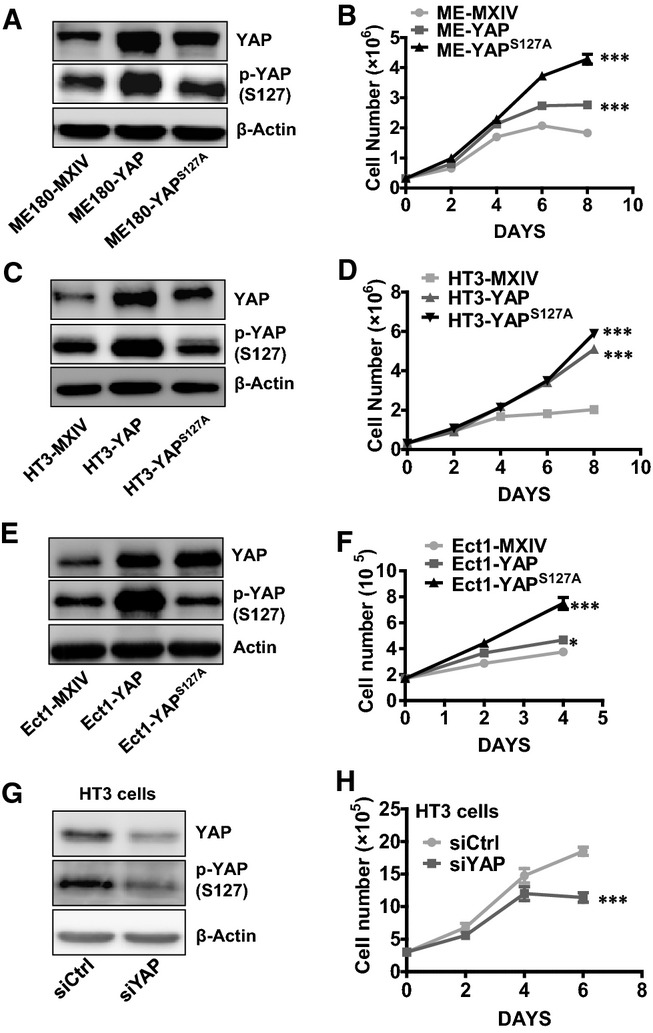
Effect of YAP on the proliferation of normal and cancerous cervical cells
A, C, E Western blot analysis showing levels of YAP and phosphorylated YAP in ME180 cell lines [ME180-MXIV (control), ME180-YAP, and ME180-YAPS127A cells] (A); HT3 cell lines [HT3-MXIV (control), HT3-YAP, and HT3-YAPS127A cells] (C); and Ect1 cell lines [Ect1-MXIV (control), Ect1-YAP, and Ect1-YAPS127A cells] (E). β-Actin was used as a protein loading control.

B, D, F Growth curves of YAP-overexpressed ME180 cell lines [ME180-MXIV (control), ME180-YAP, and ME180-YAPS127A cells] (B); HT3 cell lines [HT3-MXIV (control), HT3-YAP, and HT3-YAPS127A cells] (D); and Ect1 cell lines [Ect1-MXIV (control), Ect1-YAP, and Ect1-YAPS127A cells] (F). Each point represents the mean ± SEM (n = 4). ***P < 0.0001, ME180-MXIV vs. ME180-YAP cells and ME180-MXIV vs. ME180-YAPS127A cells on day 8. ***P < 0.0001, HT3-MXIV vs. HT3-YAP cells and HT3-MXIV vs. HT3-YAPS127A cells on day 8. ***P < 0.0001, Ect1-MXIV vs. Ect1-Ect1-YAPS127A cells on day 4. *P < 0.0074, Ect1-MXIV vs. Ect1-YAP cells on day 4.

G Western blot showing YAP levels in non-targeting control siRNA (siCtrl)- and YAP siRNA (siYAP)-transfected HT3 cells.

H Proliferation of HT3 cells treated with control (siCtrl) or YAP siRNA (siYAP). Each point represents the mean ± SEM (n = 5). ***P < 0.001 compared with siCtrl (siCtrl vs. siYAP, P = 0.0002).
Data information: Data in (B), (D), and (F) were analyzed for significance using a one-way ANOVA in GraphPad Prism 5 with Tukey’s post hoc test. Data in (H) were analyzed with an unpaired t-test in GraphPad Prism 5 with Welch’s correction. Source data are available online for this figure.